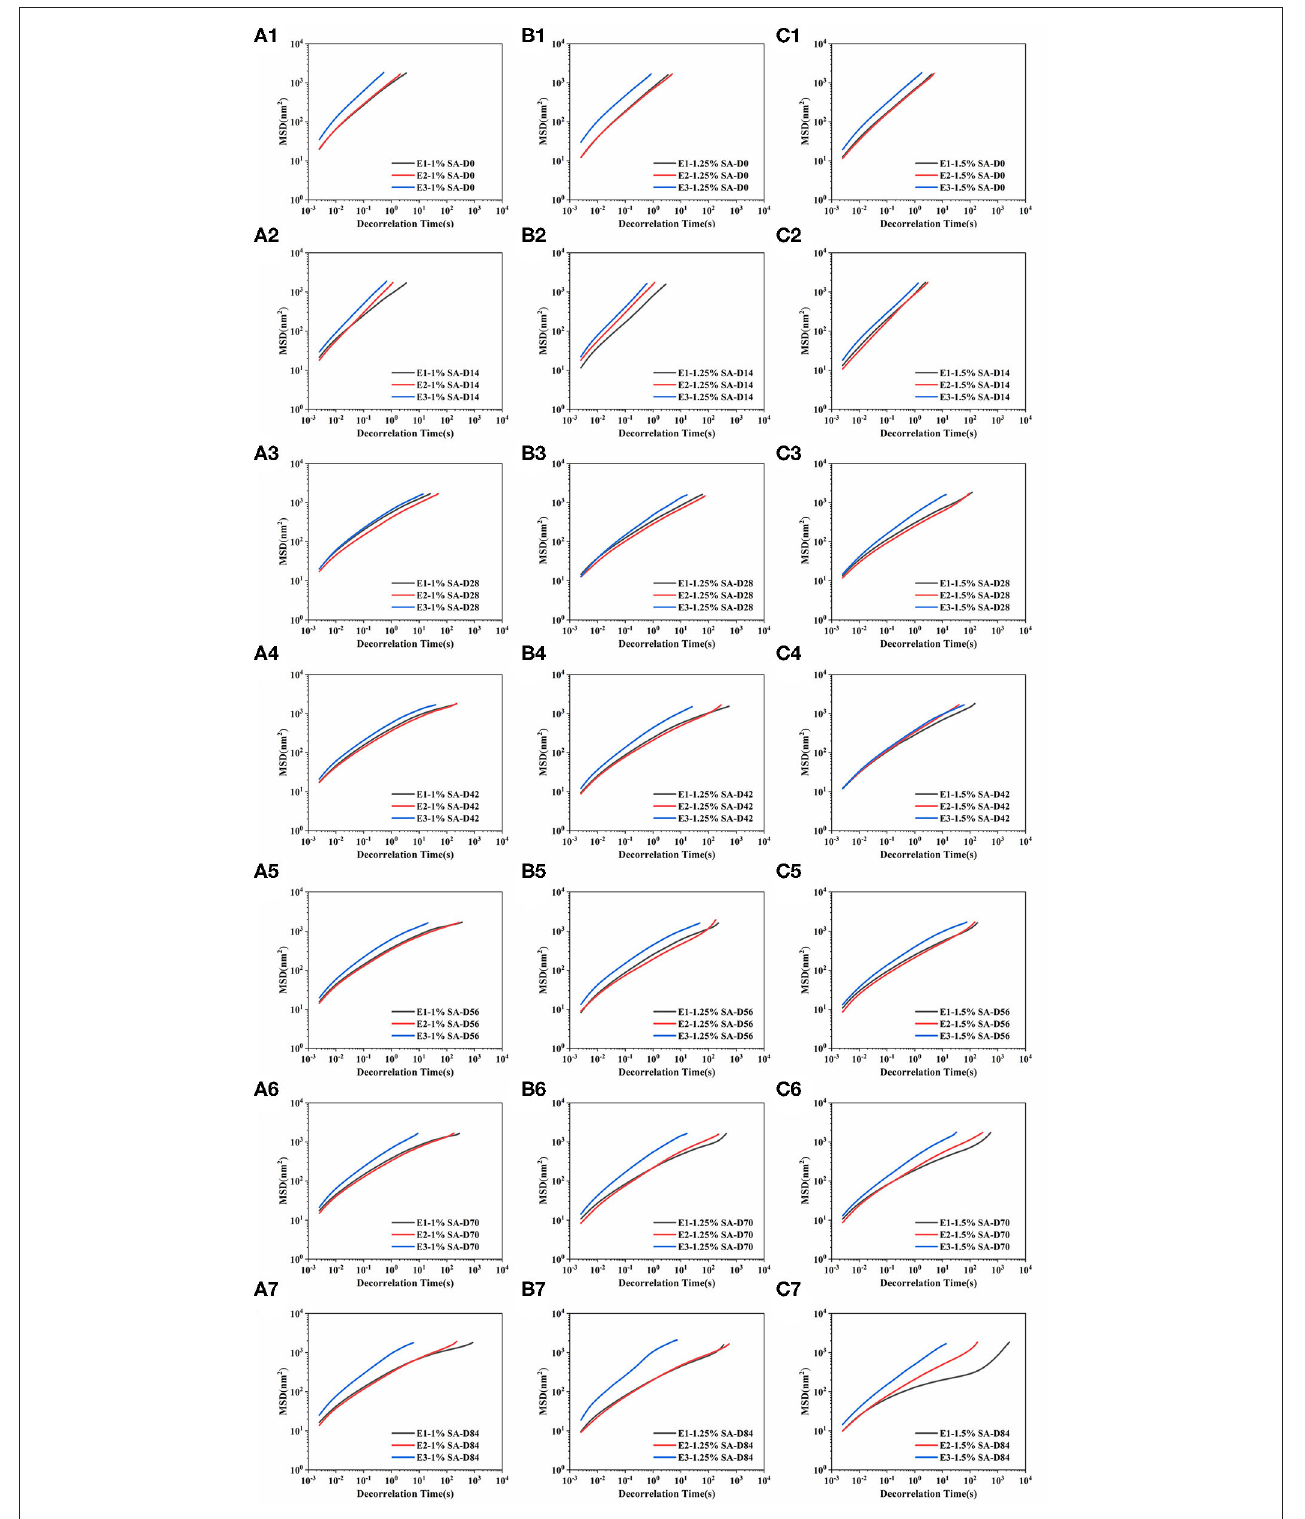
FIGURE 6 | Mean squared displacement curve: E1 emulsion stored for 0 (A1) , 14 (A2) , 28 (A3) , 42 (A4) ,56 (A5) , 70 (A6) , and 84 (A7) days, E2 emulsion stored for 0 (B1) , 14 (B2) , 28 (B3) , 42 (B4) ,56 (B5) , 70 (B6) , and 84 (B7) days, E3 emulsion stored for 0 (C1) , 14 (C2) , 28 (C3) , 42 (C4) , 56 (C5) , 70 (C6) , and 84 (C7) days. D0, D14, D28, D42, D56, D70, and D84 represent emulsions stored for 0, 14, 28, 42, 56, 70, and 84 days.